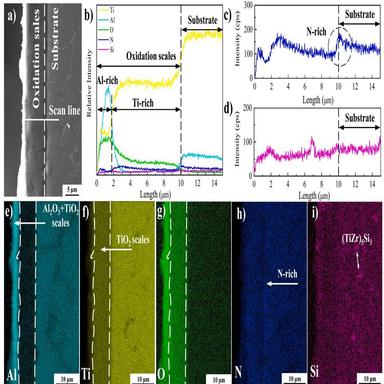
Cross-sectional micrograph and element distribution of the (TiC+TiB+(TiZr)5Si3)/TA15 composites oxidized at 800 ◦C for 100 h: (a) cross-sectional SEM micrograph, (b–d) EDS elemental line scanning along the "white line" in (a), (e–i) EDS elemental mappings of Al, Ti, O, N, Si across the (a).